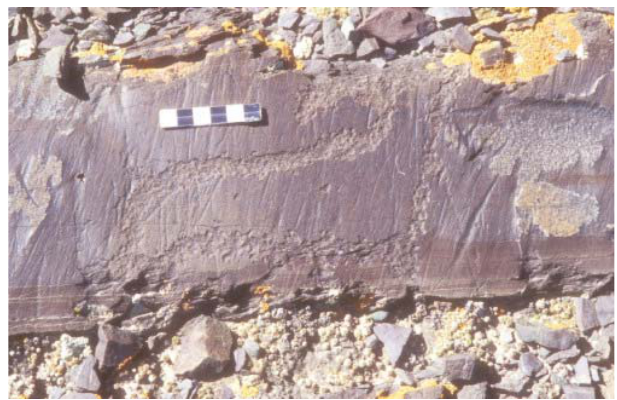
Figure 29. Broken image of an argali or ibex. Pre-Bronze Age. Upper Tsagaan Gol.